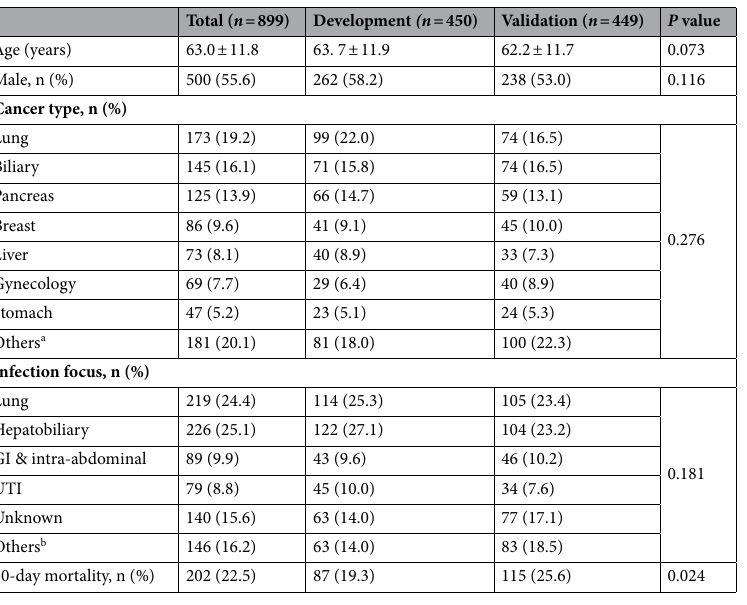
Table 1. Baseline characteristics of total population. Values are expressed as the mean ± standard deviation and the number (%). GI gastrointestinal, UTI urinary tract infection. a Others in cancer type: esophagus, duodenum, small bowel, colon, rectum, head & neck, prostate, renal, bladder, thymoma. b Others in infection focus: bone & soft tissue, bacteremia, febrile